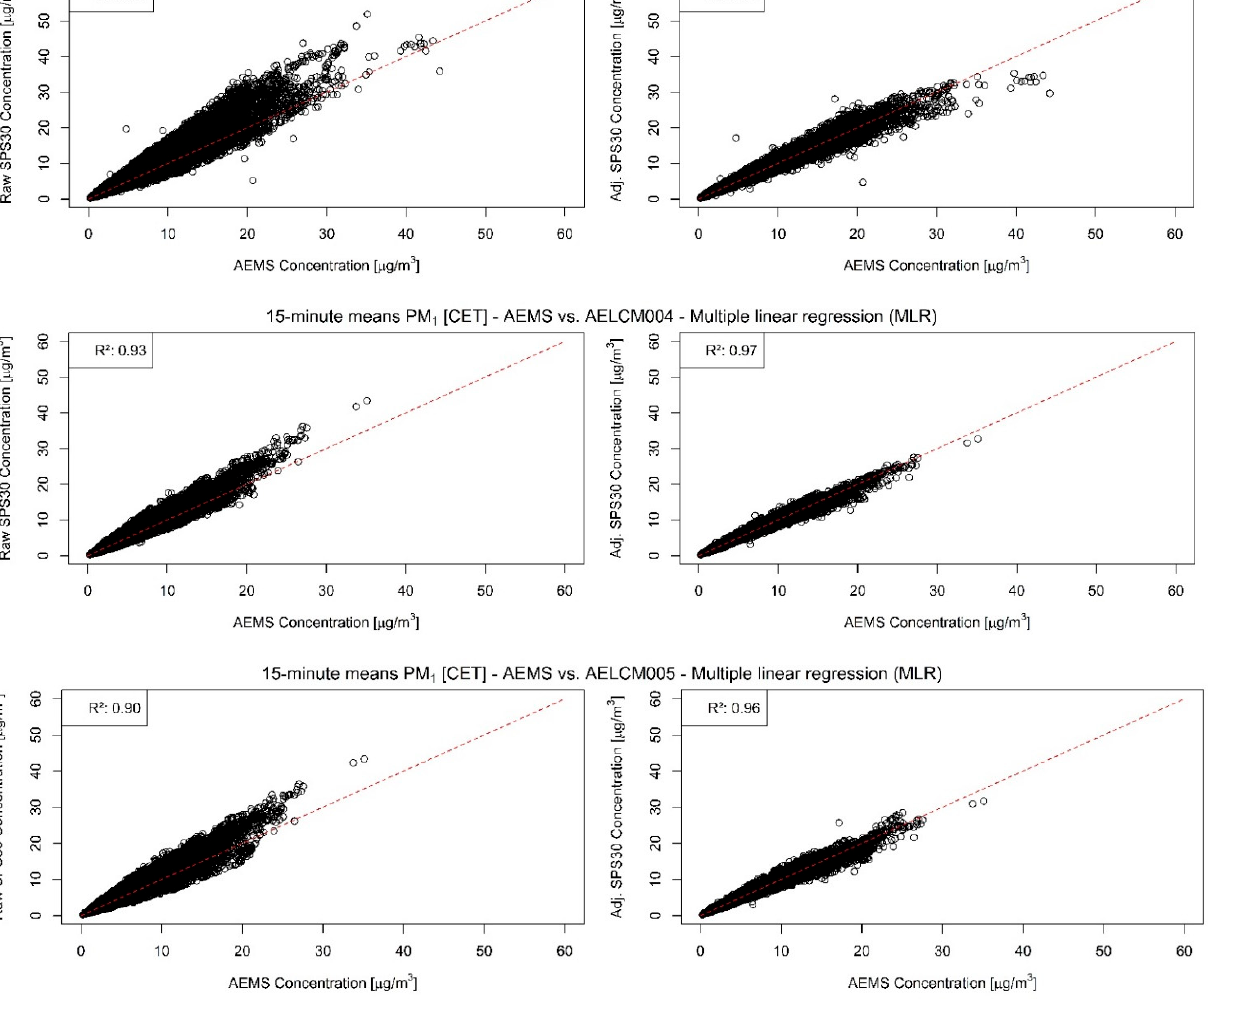
Figure 5. Raw ( left ) and model-adjusted ( right ) 15 min concentration means of different deployed SPS30 vs. 15 min concentration means of reference measurements given by the AEMS for PM1 in µ g/m 3 : ( Top ) SPS30 deployed in AELCM003; ( Middle ) SPS30 deployed in AELCM004; and ( Bottom ) SPS30 deployed in AELCM005. Multiple linear regression is used for adjusting the raw LCS data.